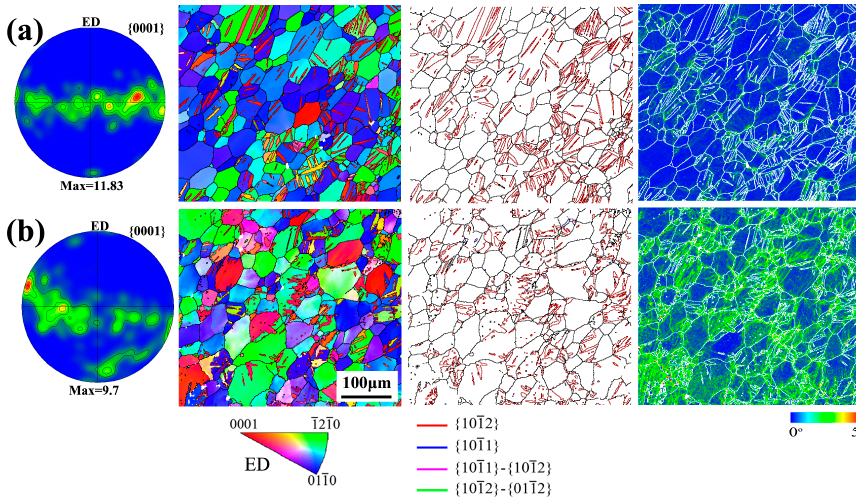
Figure 3. Pole figures and EBSD maps of the torsion-deformedAZ91 rod: ( a ) center position; ( b ) edge position.